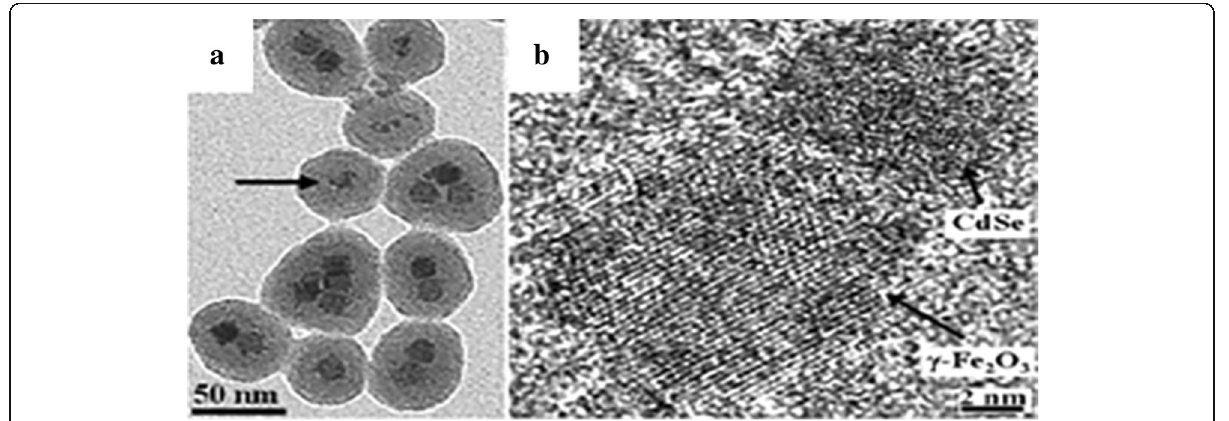
Fig. 14 a TEM image and b HRTEM image of SiO 2 /MP-QD nanoparticles